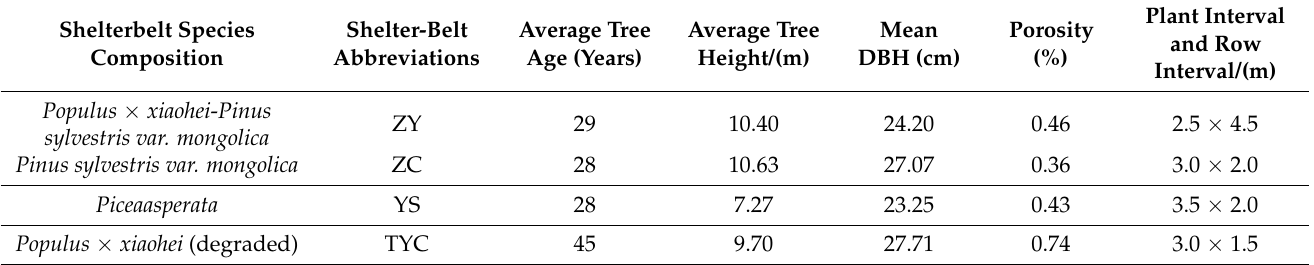
Table 1. Basic situation of farmland protection shelterbelt.